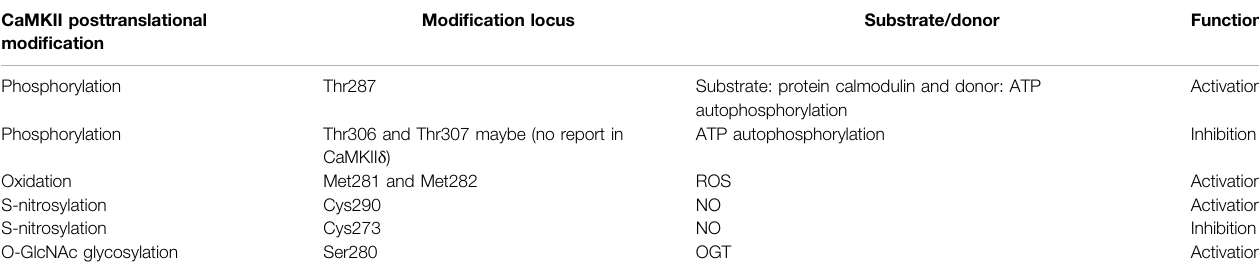
TABLE 1 | Overview of CaMKII posttranslational modi fi cation (CaMKII δ as an example). CaMKII posttranslational modi fi